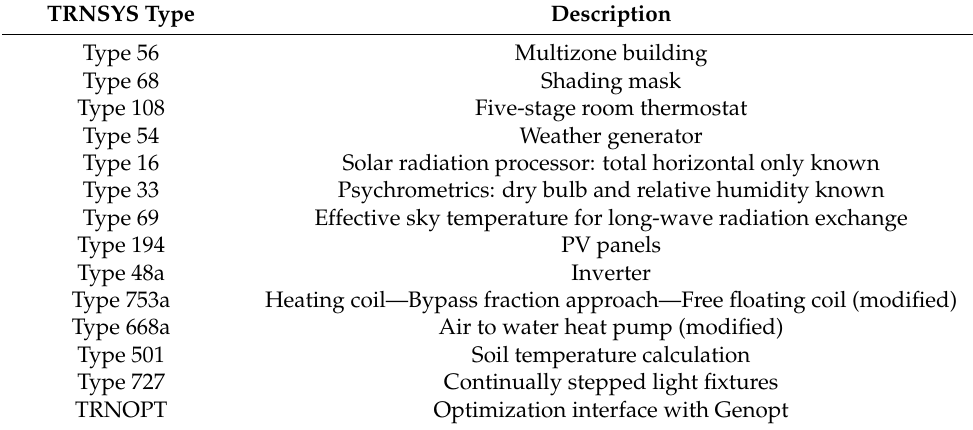
Table 2. TRNSYS component models (Types) employed in the simulation.